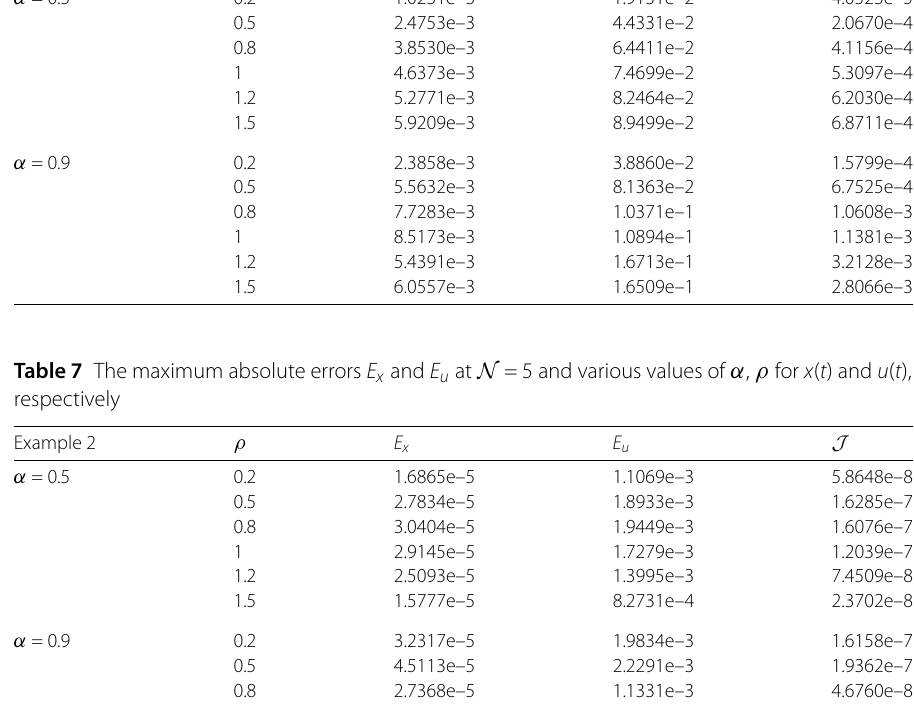
Table 6 The maximum absolute errors E x and E u at N = 3 and various values of α , ρ for x ( t ) and u ( t ), respectively Example 2 ρ E x E u J α = 0.5